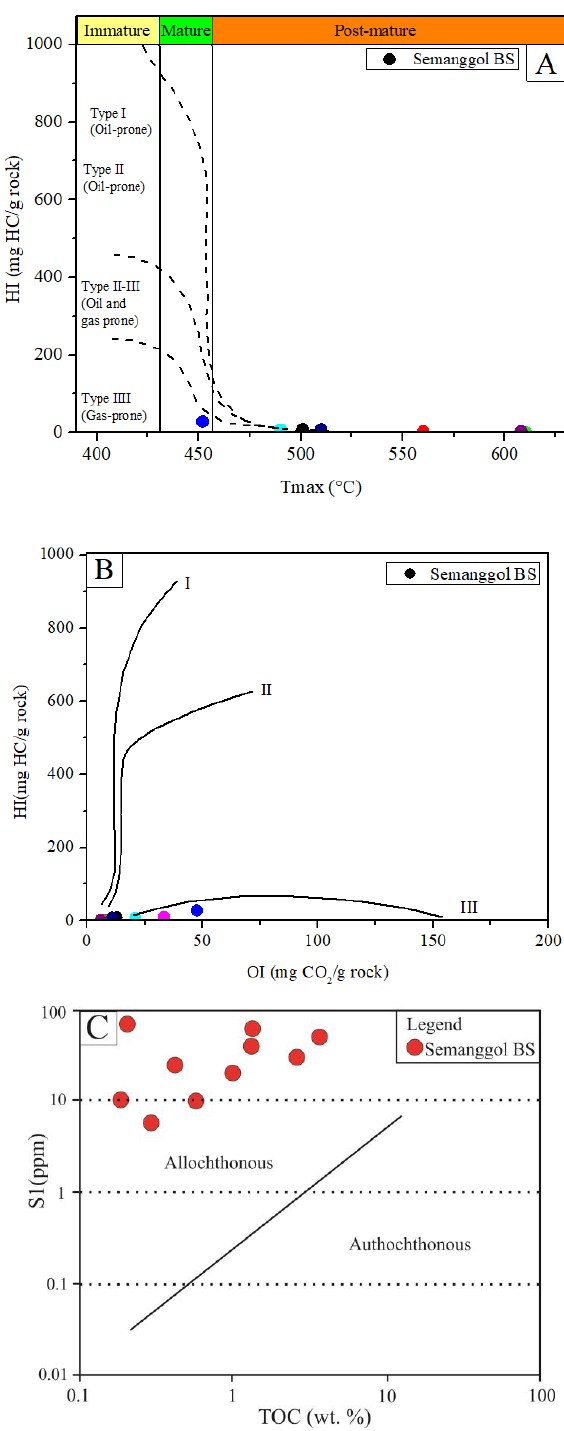
Figure 5. ( A ) Plot of T max vs. hydrogen index (HI) showing generative source rock potential for